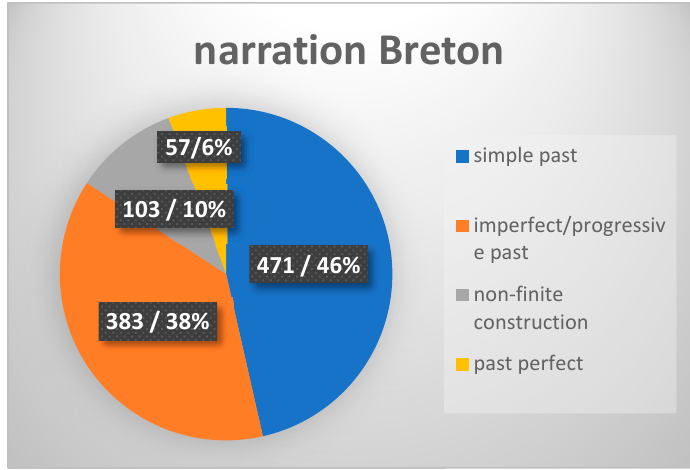
Figure 2. Distribution of Breton past forms in corpus A (narrative discourse).